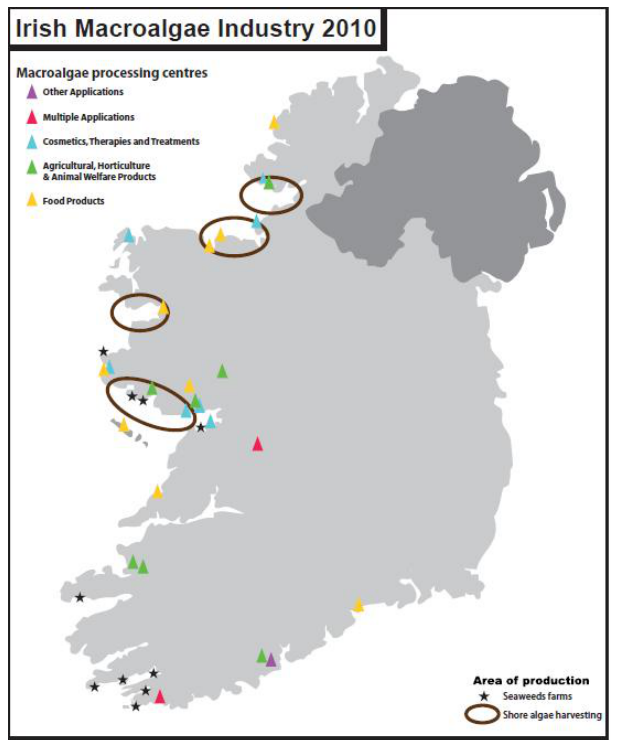
Figure 5. Irish macroalgae industry 2010 [61].